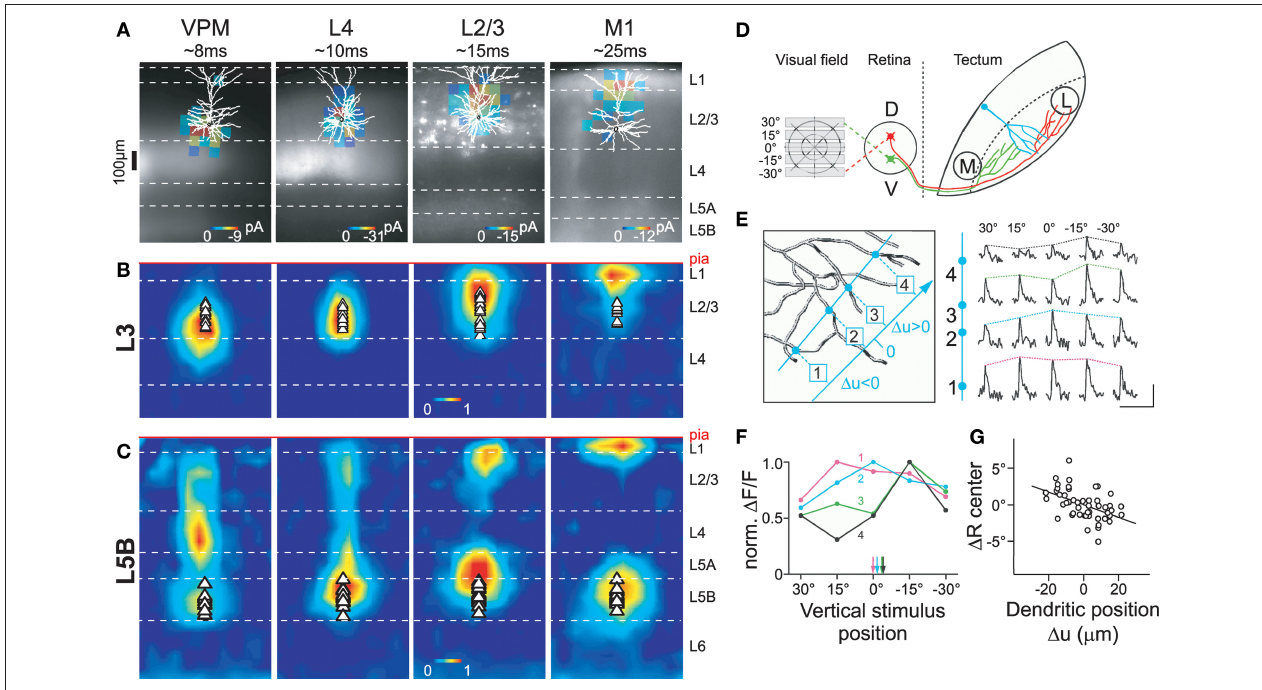
Note that L2/3 and M1 inputs impinge onto both the basal dendrites and the apical tuft. Individual maps were aligned at the pia. Triangles indicate soma position. (D) Retinal input to dendrites of tectal neurons was elicited by presenting horizontal bars at different positions within the visual field of Xenopus tadpoles. (e) Line scans (blue) across 4 dendritic branches of one tectal neuron filled with the calcium-sensitive dye OGB-1 (left) reveal differential responses of the branches to the same stimulus position. Scale bar, 50% ∆ F/F, 5 s. (F) Plotting normalized responses against stimulus position suggests branch-specific retinotopic input tuning. Arrows indicate centers of mass for each branch. (g) The mean subtracted center of mass ( ∆ R center) correlates with the relative position of a branch in the tectum. Reproduced with permission from (Petreanu et al., 2009) (A–C) and (Bollmann and Engert, 2009) (D–g)